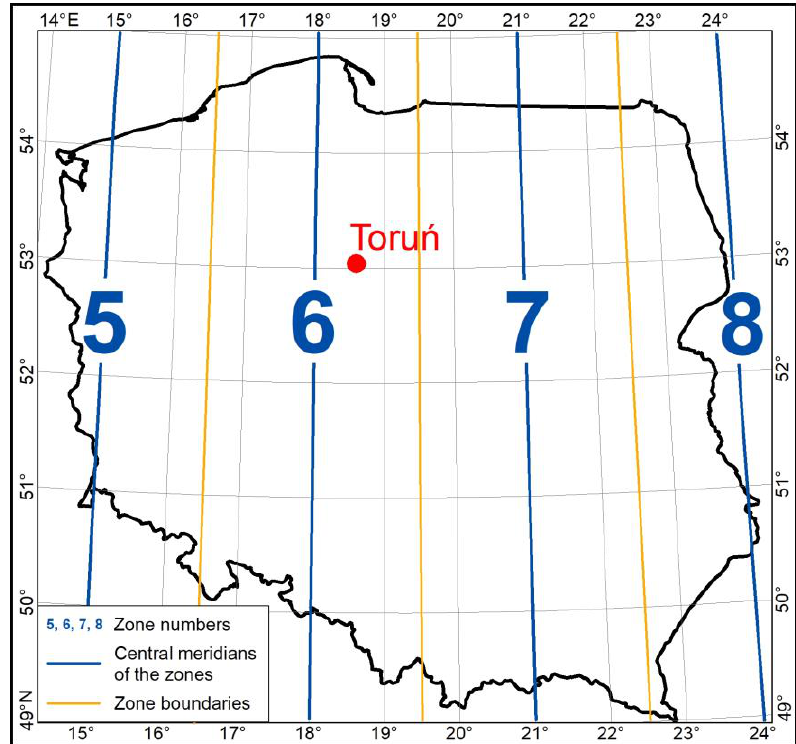
Figure 5. The State Geodetic Coordinate System 2000 (PUWG PL-2000) currently applicable in Poland. Source: own work made with Natural Earth. Free vector and raster map data @ naturalearthdata.com.